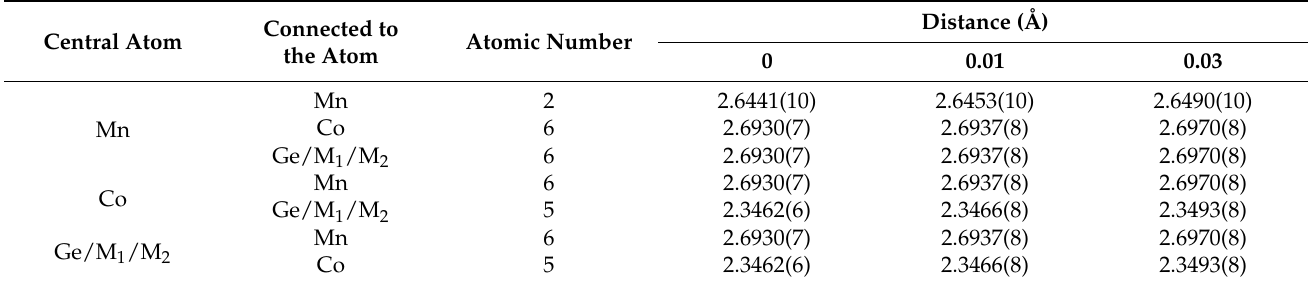
Table 3. The number of different atoms of each central atom and its nearest neighbor.